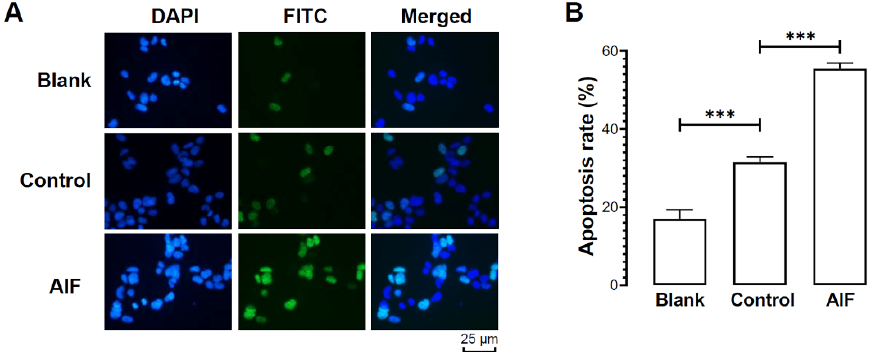
Figure 6. Apoptotic property of HEK293T cells transfected with pcDNA3.1/HA/ Hl AIF-2 recombi- nant plasmid. ( A ) Detection of apoptosis by TUNEL assay. “DAPI” represents the DAPI-stained cell nuclei; “FITC” represents the FITC-stained fractured DNA fragments (marker for apoptosis); “Merged” represents the combination of cell nuclei and fractured DNA fragments. ( B ) Comparison of apoptosis rates for HEK293T cells in different groups. “Blank” represents the blank group (untransfected HEK293T cells); “Control” represents the control group (HEK293T cells transfected with pcDNA3.1/HA); “AIF” represents the experimental group (HEK293T cells transfected with pcDNA3.1/HA/ Hl AIF-2). The values are expressed as mean ± SE ( n = 3), and significant difference was analyzed by the Student’s t -test and shown as *** p < 0.001.